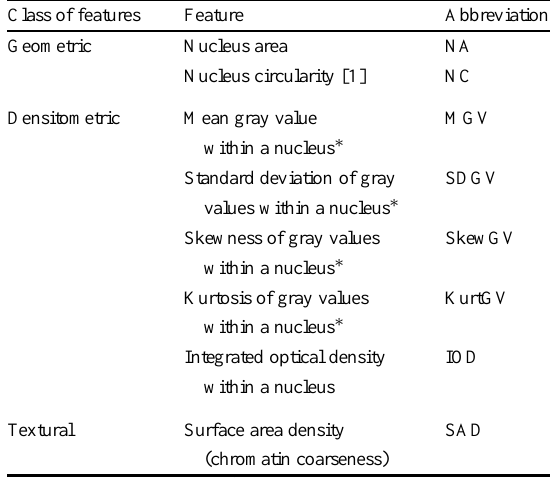
Nuclear features measured, with corresponding abbreviations Class of